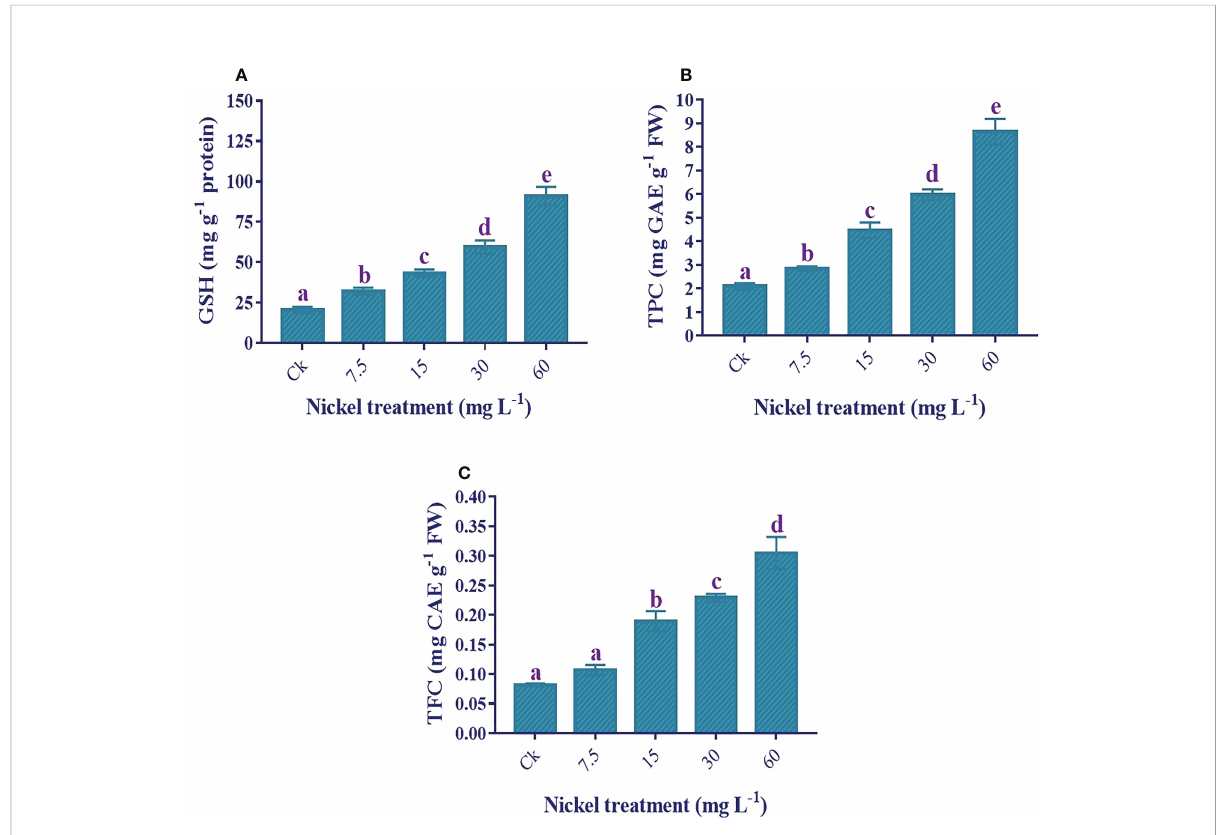
FIGURE 9 Effect of different Ni treatments on the antioxidants in the leaves of sweetpotato. (A) GSH, (B) total polyphenols, and (C) total fl avonoids. According to the Duncan test, different letters indicate a signi fi cant difference ( p < 0.05) among the fi ve treatments. The error bars represent the mean ±